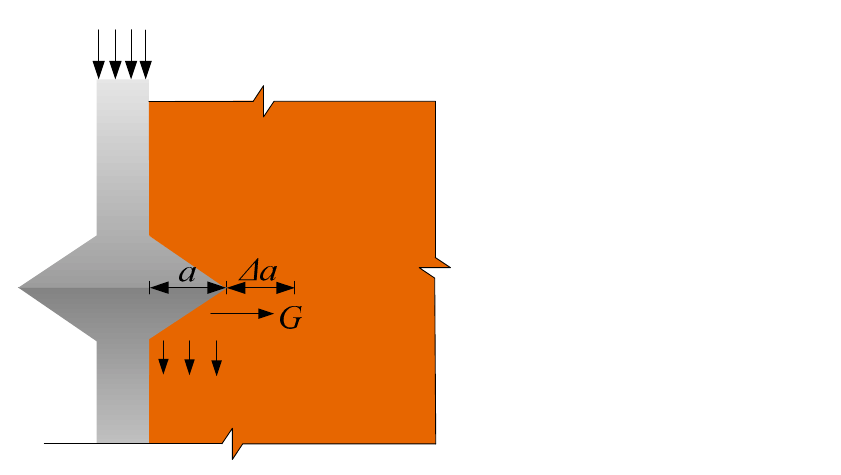
Figure 10. Schematic diagram of undisturbed soil cracking under force at the tip of the expanded body (a is the length of the expanded body; Δ a is the newly expanded crack length; G is crack prop- body (a is the length of the expanded body; ∆ a is the newly expanded crack length; G is crack propagation force).